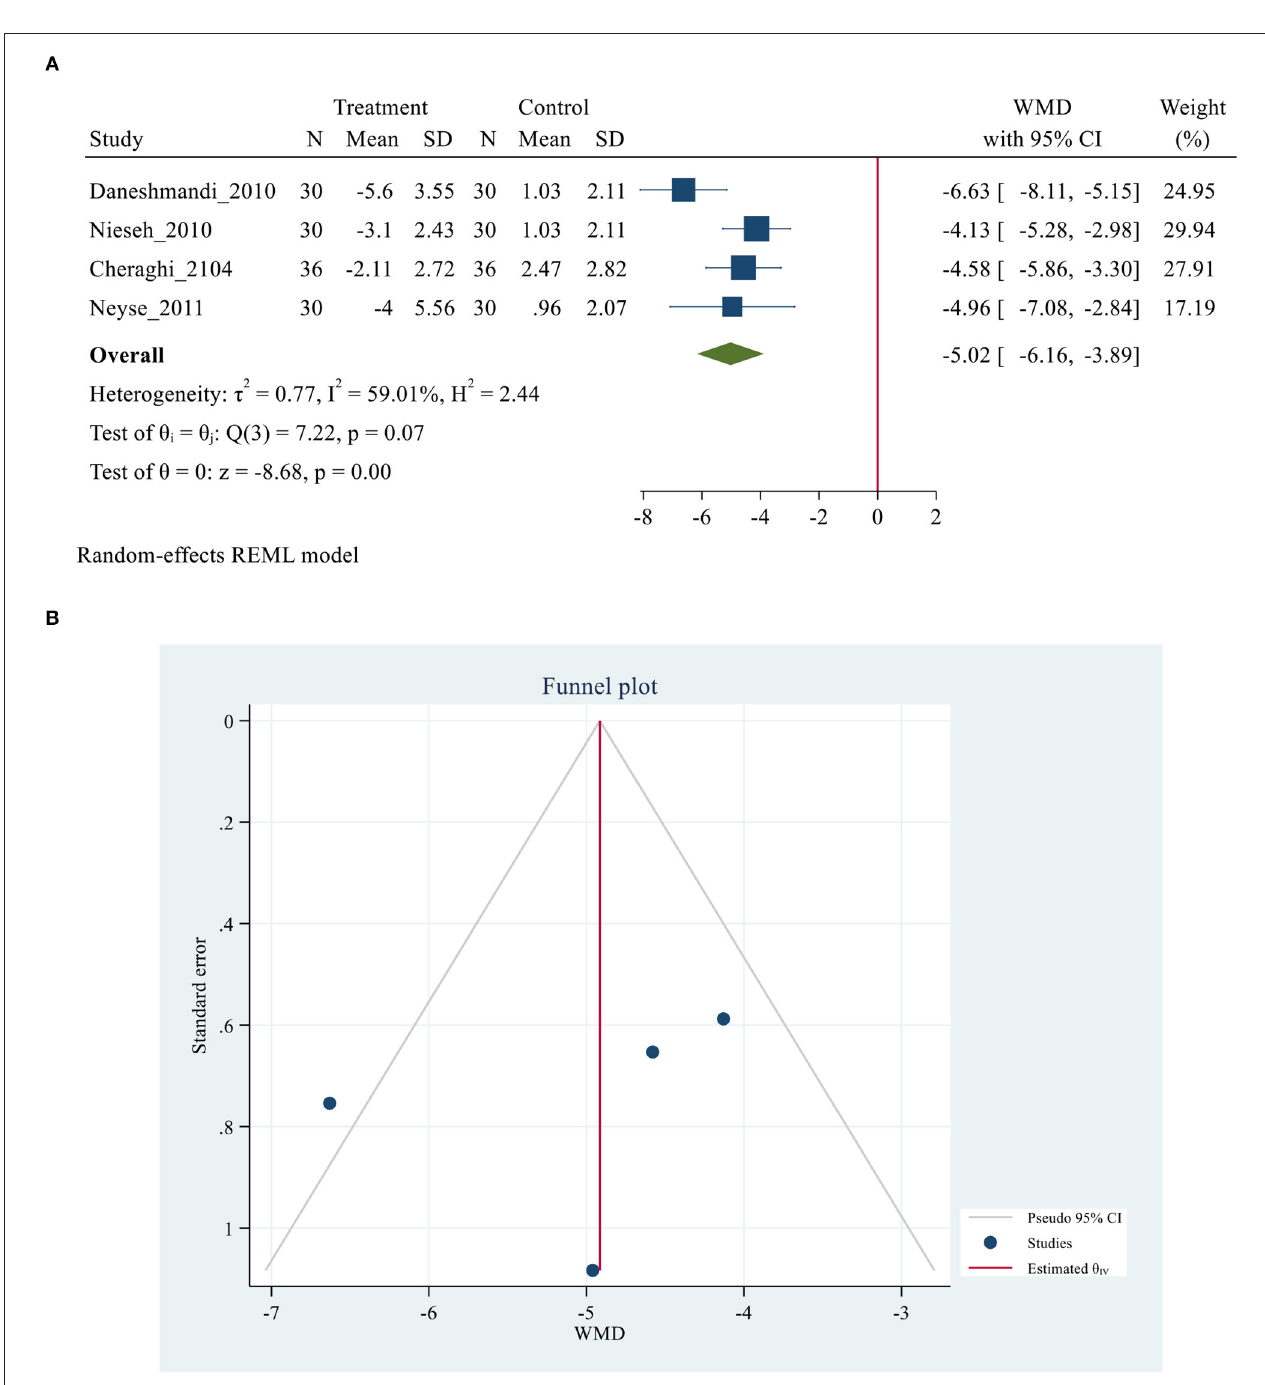
FIGURE 2 | (A) Forest plot of mean difference (MD) for sleep quality based on PSQI between intervention and control groups. (B) Funnel plot showing publication bias on PSQI -based sleep quality.